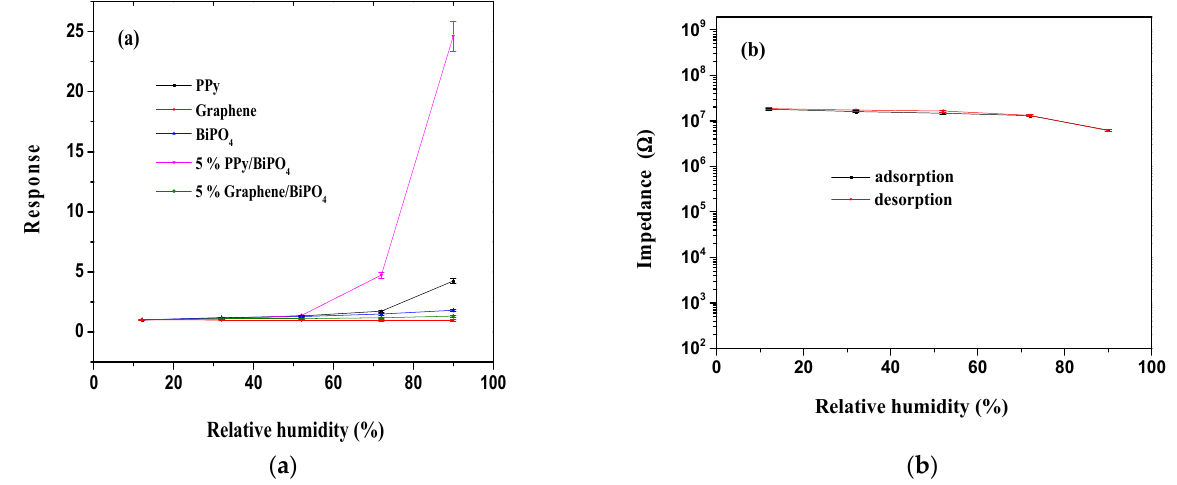
Figure 6. ( a ) Discrepancies in response relative to the variations in relative humidity (%) for varying (Gr/PPy)-BiPO 4 composite contents; ( b ) hysteresis characteristics of 5 wt.% PPy/BiPO 4 composite.